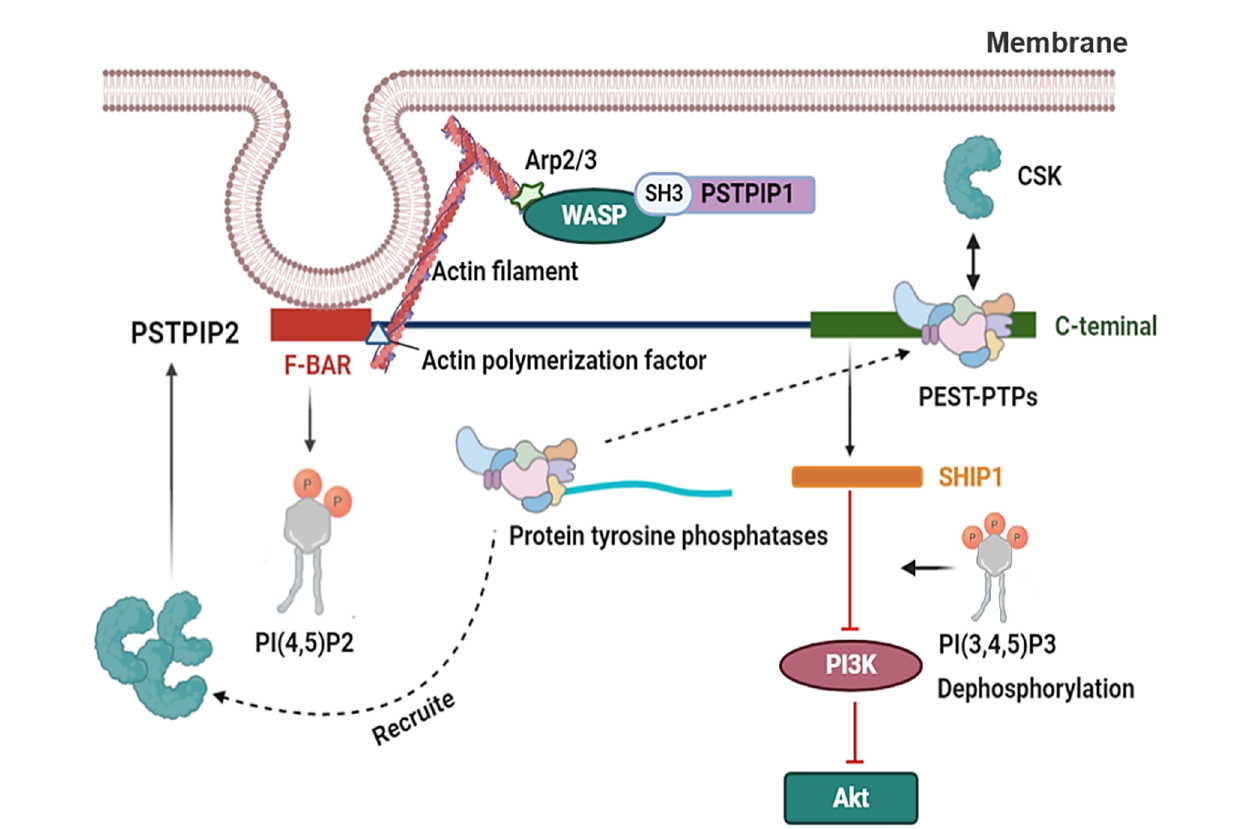
FIGURE 4 | The related mechanism of PSTPIP2. PSTPIP2 have a N-terminal F-BAR domain and a C-terminal tail. The PSTPIP2 C-terminal can be combined with PEST- family and the inhibition of PSTPIP2 is mediated by protein tyrosine phosphatases located in the central area of PEST-family. PEST-PTPs can bind to CSK through a proline-rich or tyrosine-rich motif in their central region. PEST-PTPs also involves recruiting CSK to PSTPIP2, which further enhances the independent binding of CSK to PSTPIP2. SHIP1 binds to the key tyrosine residues at the C terminal of PSTPIP2. Lipid phosphatase SHIP1, a regulatory protein, controls the activity of the PI3K pathway via dephosphorylating its crucial mediator, phosphatidylinositol-3,4,5-trisphosphate [PI (3,4,5) P3]. This results in the decreased activity of some of its downstream effectors, such as Akt. PSTPIP2 regulate membrane curvature by binding to cell membrane phospholipids by F-BAR domain. F-BAR could bind to actin polymerization factor of actin fi lament. WASP binds to the Arp2/3 complex and triggers the formation of a weave of actin comprising branched actin fi laments. And the SH3 domain of PSTPIP1 could interact with